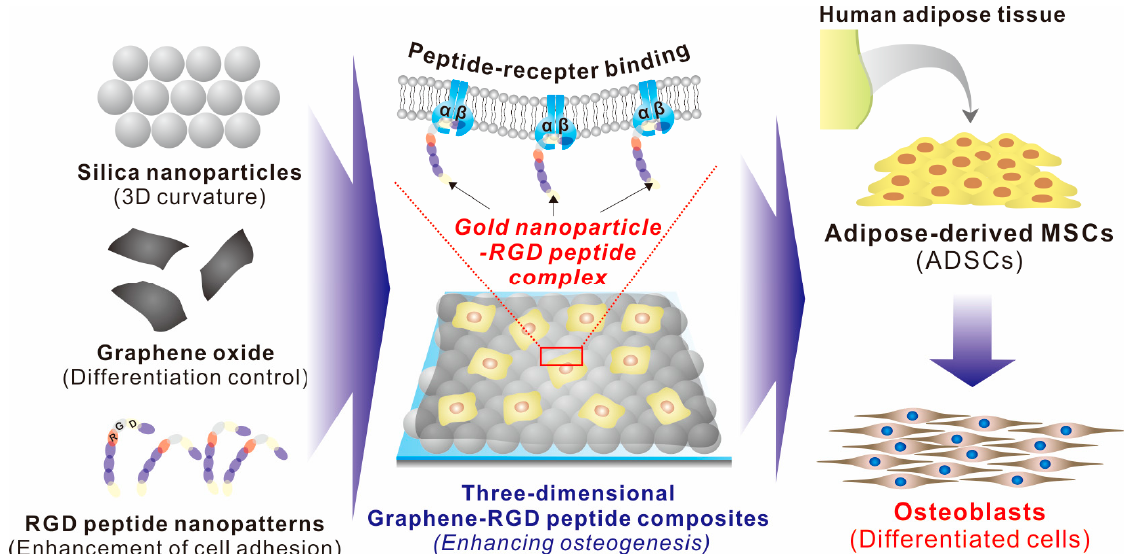
Figure 1. Schematic diagram of three-dimensional graphene/arginine-glycine-aspartic acid (RGD) peptide composites for enhancement of adipose-derived mesenchymal stem cell (ADSC) osteogenesis.